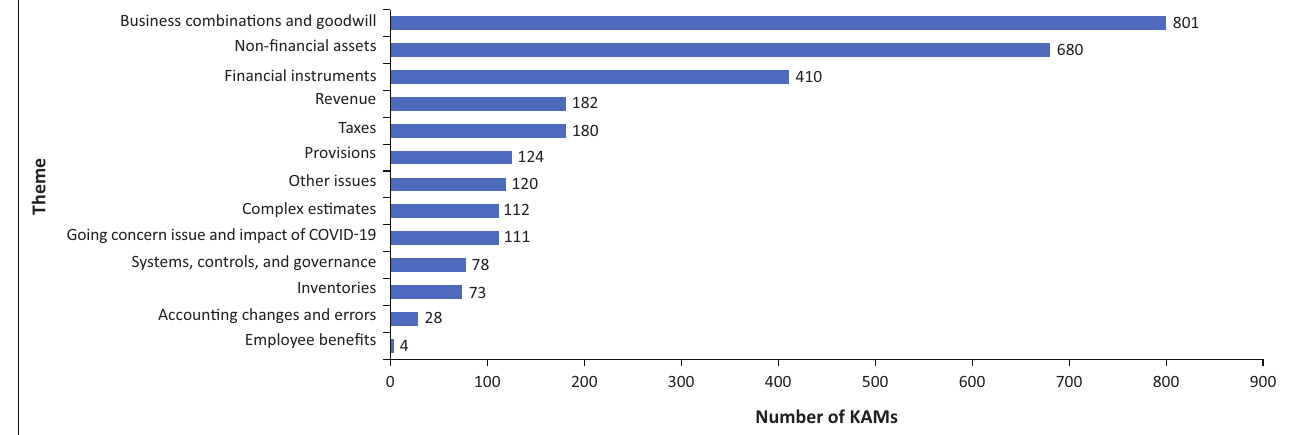
FIGURE 1: Total reported key audit matters per year in South